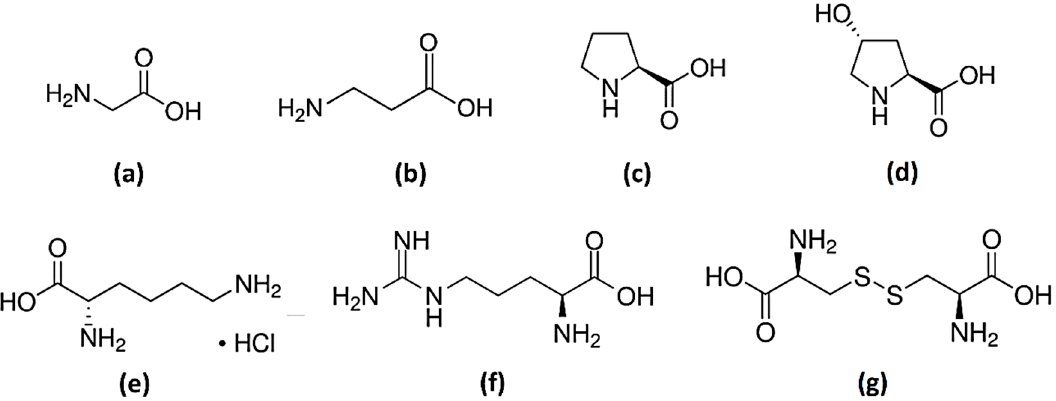
Figure 1. Chemical structures of amino acids: ( a ) glycine (Gly); ( b ) β -alanine (Ala); ( c ) L-proline (Pro); ( d ) trans - 4-hydroxy-L-proline (OH-Pro); ( e ) L-lysine monohydrochloride (Lys·HCl); ( f ) L-arginine (Arg); and ( g ) L-cystine (Cys).